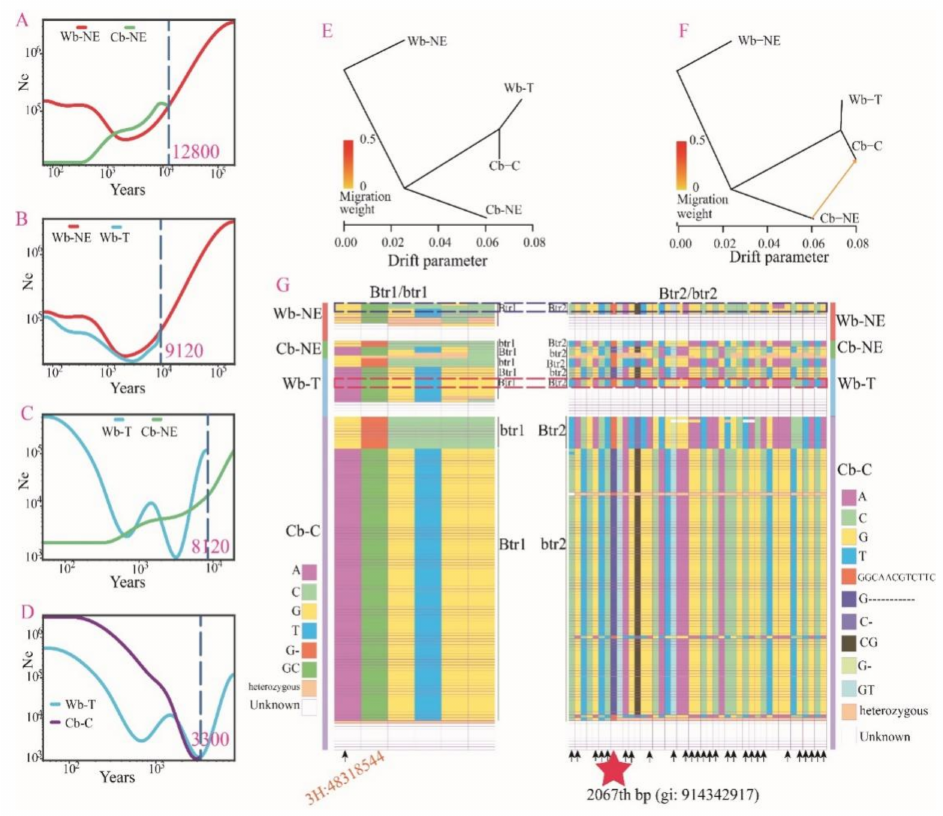
Figure 3. Origin of Wb-T and its genetic relationship with Cb-C. Wb-NE, wild barley from the Near East Fertile Crescent. Wb-T, wild barley from the Tibetan Plateau. Cb-C, cultivated barley from China. Cb-NE, cultivated barley from the Near East Fertile Crescent. ( A – D ) Effective population size (Ne) changed for the four groups and estimated divergence time between Wb-NE and Cb-NE ( A ), between Wb-NE and Wb-T ( B ), between Cb-NE and Wb-T ( C ), and between Wb-T and Cb-C ( D ) were inferred by SMC++. Estimated divergence time is denoted by the blue dotted line and was assumed one generation per year. The mutation rate was 6.5 × 10 − 9 per site per generation. ( E , F ) Inference of population splits with 0 mixture events ( E ) and 1 mixture event ( F ) by TreeMix. Admixture events are indicated by arrows and the arrow color denotes the migration weight. ( G ) Haplotype heatmaps at Btr1 / btr1 and Btr2 / btr2 loci in 153 accessions (124 resequencing + 29 RNA sequencing). Key variations are denoted by red font in the Btr1 / btr1 heatmap and the star in the Btr2 / btr2 heatmap. Accessions in the Btr1 / btr1 heatmap were corresponded with those in the Btr2 / btr2 heatmap. Arrows below the accessions indicate that the accessions show differences in SNP or InDel sites in the Wb-NE accessions (blue dashed box) and the Wb-T accessions (red dashed box), though both of them exhibit the Btr1Btr2